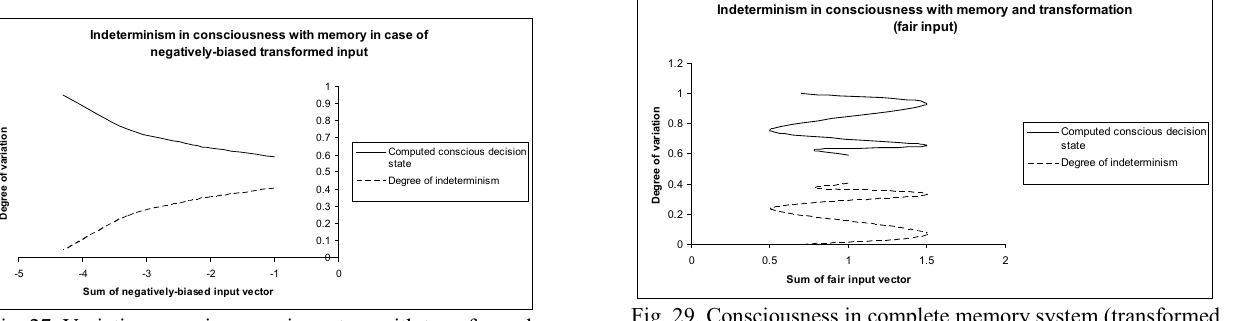
Fig. 27. Variation consciousness in system with transformed excitation ( (cid:16) biased C2).